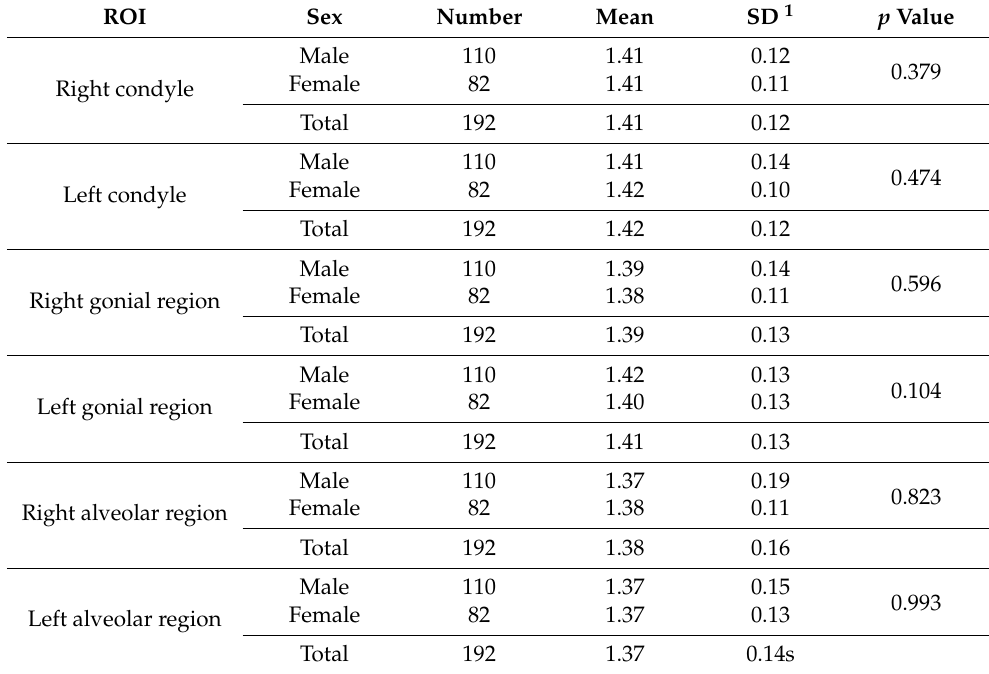
Table 4. FD values of different ROIs for the two sexes in the non-bruxer group. ROI